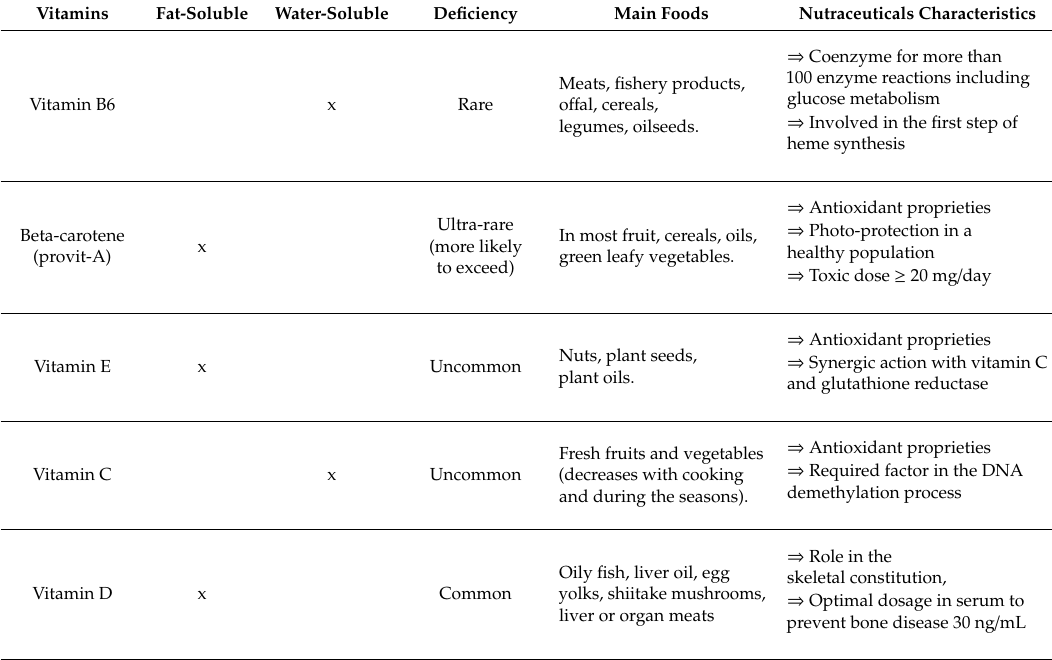
Table 1. Characteristics of